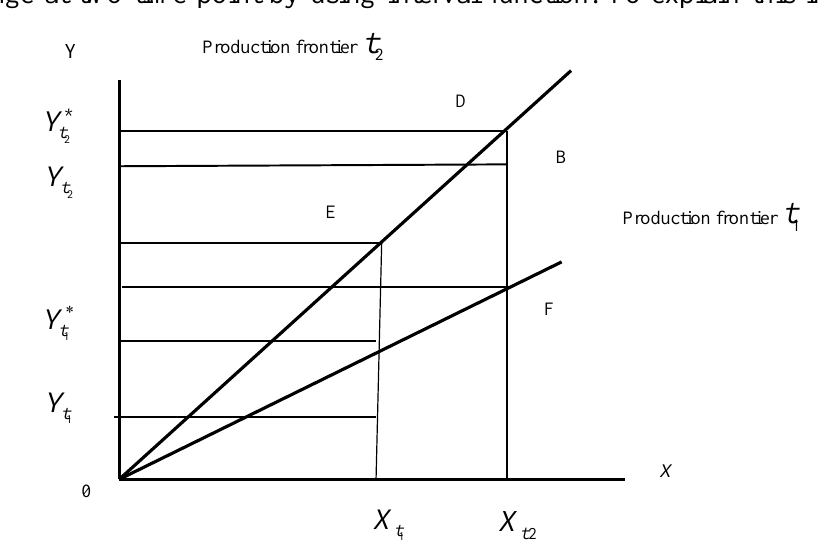
Fig. 1. Description of Malmquist index